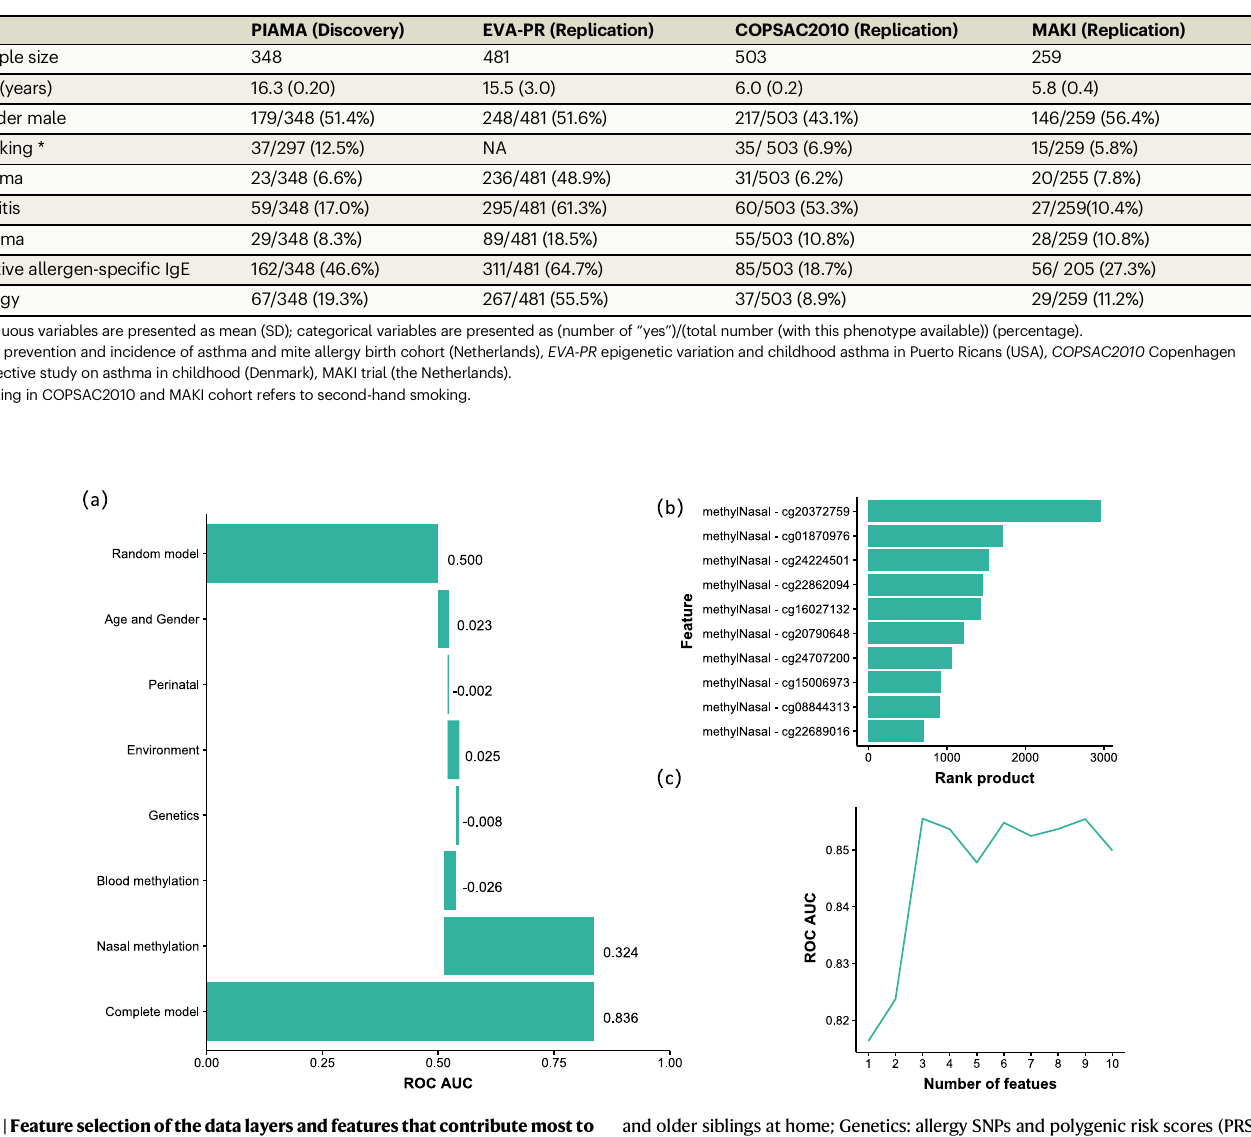
Table 1 | Characteristics of the discovery and replication cohorts